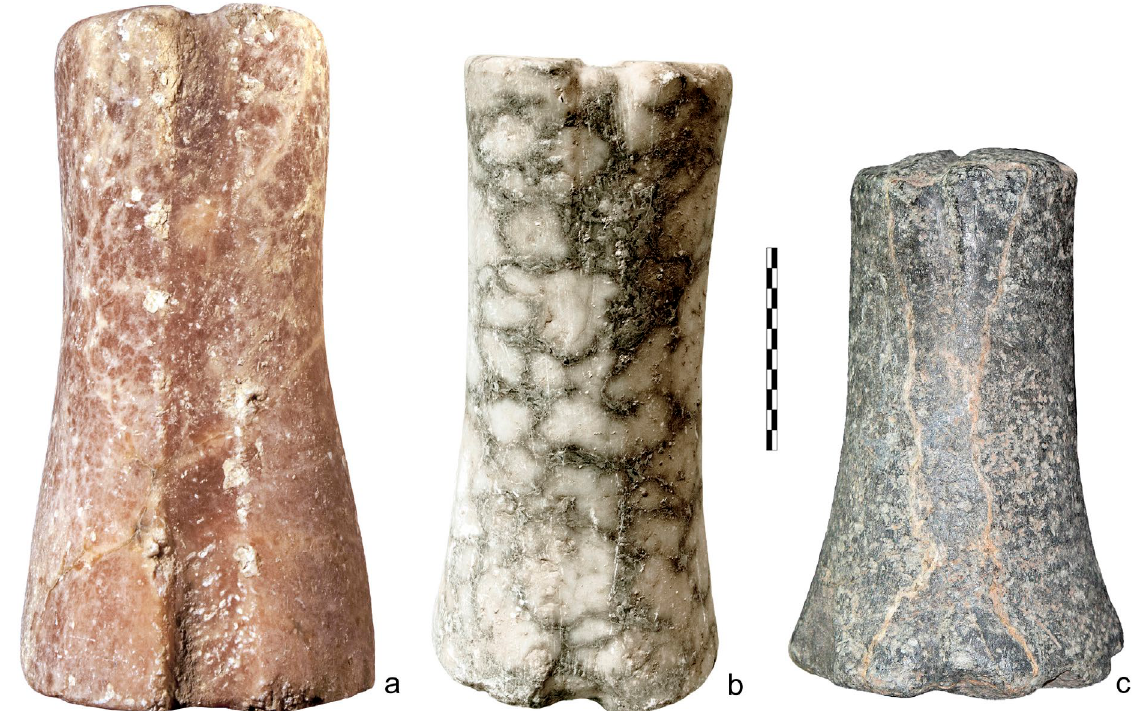
Figure 14. Various types of miniature columns from Ulug Depe (a, b) and Adjikui Depe (c) (from the depositories of the National Museum of Turkmenistan, Ashgabat): a, с. truncated -conical; b. biconical. Scale bar is 10 cm long, separated into 1 cm